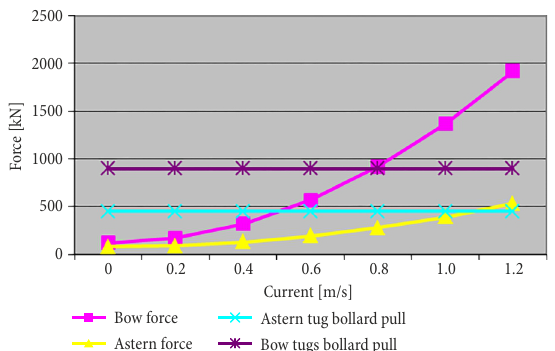
Fig. 16. Forces created by the wind of 10 m/s perpendicular to the ship and the current acting at an angle of 70° to the ship’s hull and 2 tugs work on ship bow and 1 tug work on ship astern (each tug has the capacity of 500 kN bollard pull) bollard pull, received by methods presented in the article